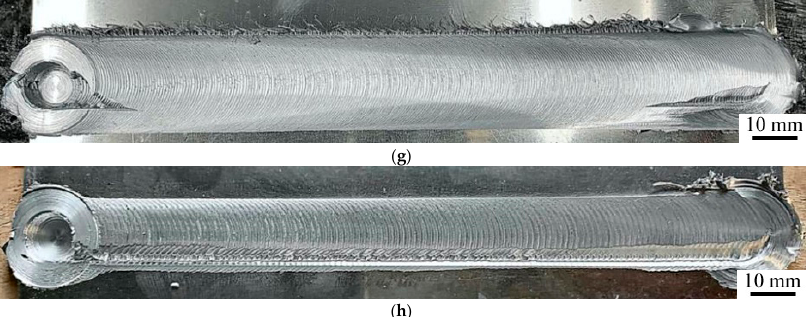
Figure 4. The FSW joints: ( a ) CW1; ( b ) CW3; ( c ) CW4; ( d ) CW5; ( e ) CW6; ( f ) CW7; ( g ) CR4; ( h ) CR7.